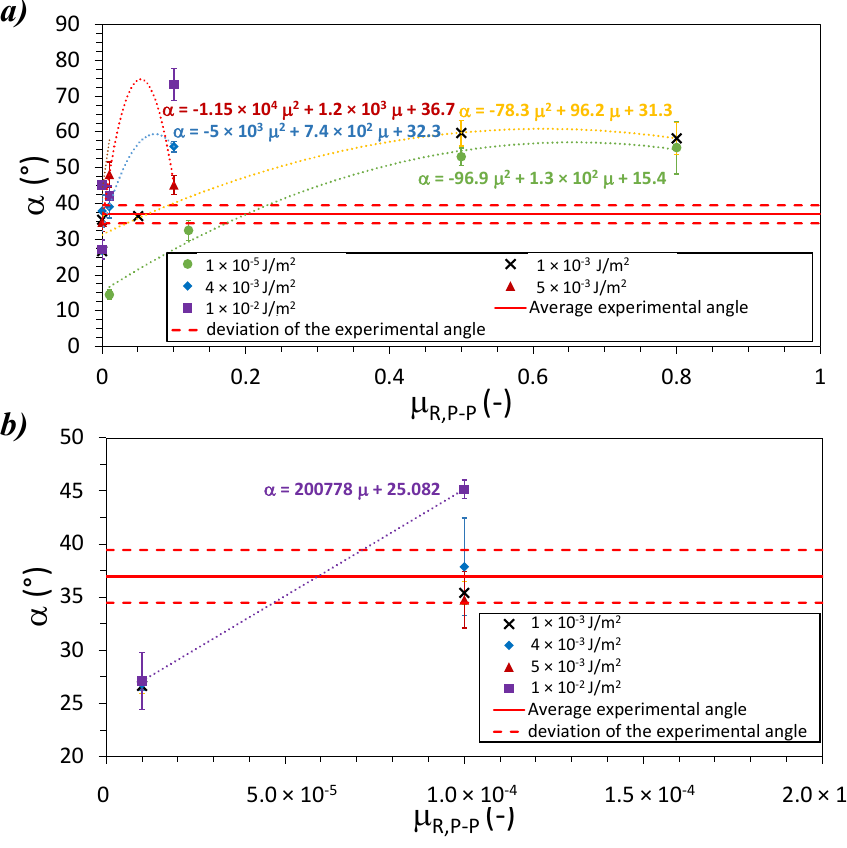
Figure 9. ( a ) Static angle of repose ( α ) as function of the coefficient of rolling friction between the particles ( µ R, P − P ) for different values of the interfacial adhesive surface energy between the particles ( Γ (cid:2900)(cid:2879)(cid:2900) ): ● , 1 × 10 −5 J/m 2 ; × , 1 × 10 −3 J/m 2 ; ♦ , 4 × 10 −3 J/m 2 ; ▲ , 5 × 10 −3 J/m 2 ; ■ , 1 × 10 −2 J/m 2 . Dotted lines using the same colours of simulation results are the interpolating polynomials for resulting α at constant Γ . The continuous red line and red hyphenated lines correspond to the experimental average value of α and its standard deviation range, respectively; ( b ) zoom of data in the range 0 ÷ 1 × 10 − 4 with the regression line in case of Γ P − P =1 × 10 − 2 J/m 2 .